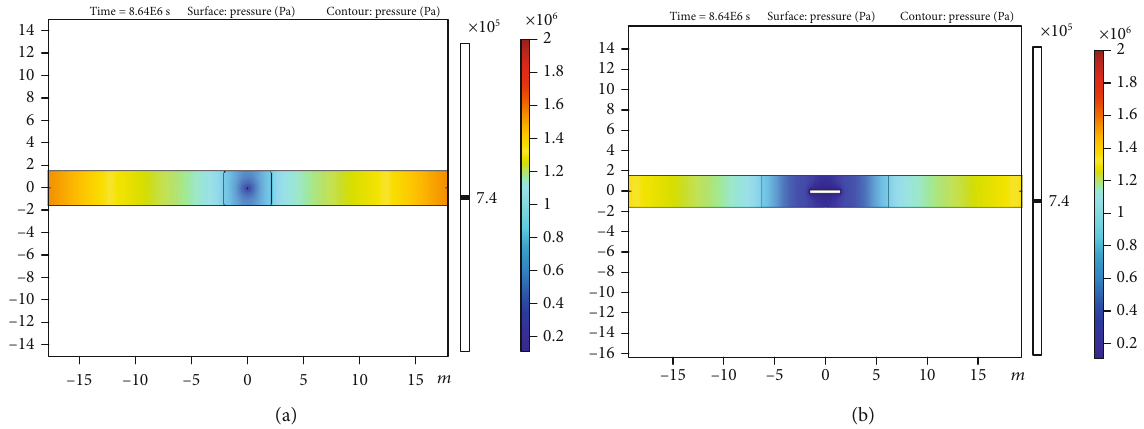
Figure 7: Comparison of a (a) traditional borehole and (b) slotted borehole after 100 days of extraction.